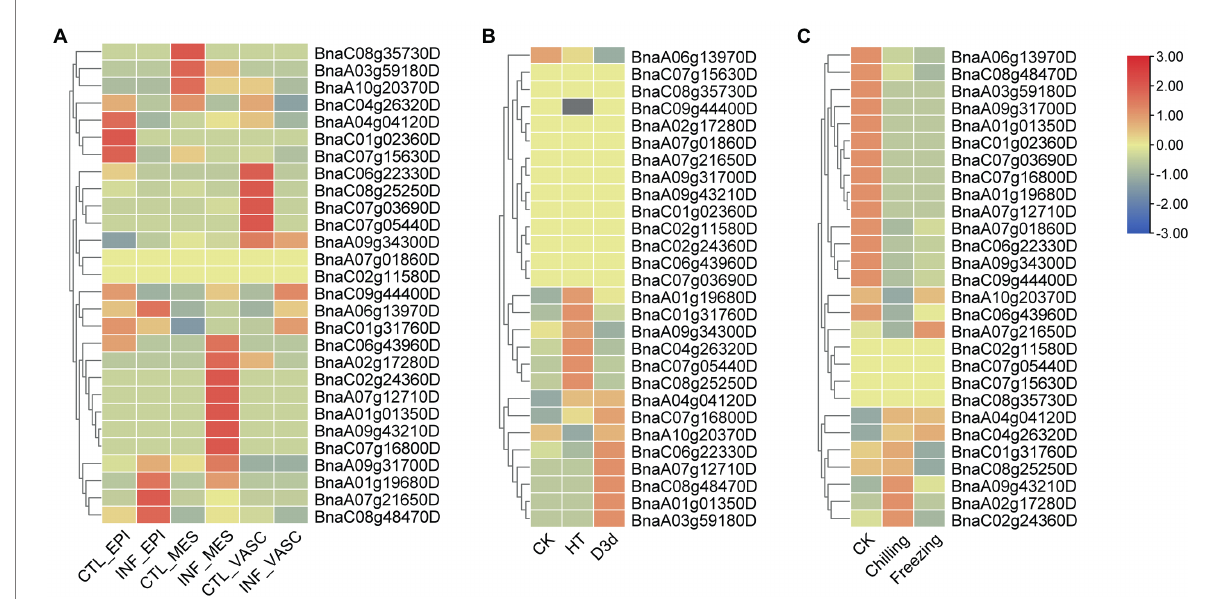
FIGURE 10 The expression patterns of BnSHI/STYs . (A) The expression pattern of BnSHI/STYs after infection by Sclerotinia sclerotiorum . (B) The expression pattern of BnSHI/STY in B. napus under abiotic stress. (C) The expression pattern of BnSHI/STYs in cold stress. RNA sequence data that were treated with cold shock at temperatures of chill (4 ° C) and freezing (4 ° C) were used to complete this figure, and “CK” was treated at 25 ° C. Genes with high expression levels are shown in red, and genes with low expression levels are shown in blue. The gray box indicates that the expression data of this gene were not found in the database.